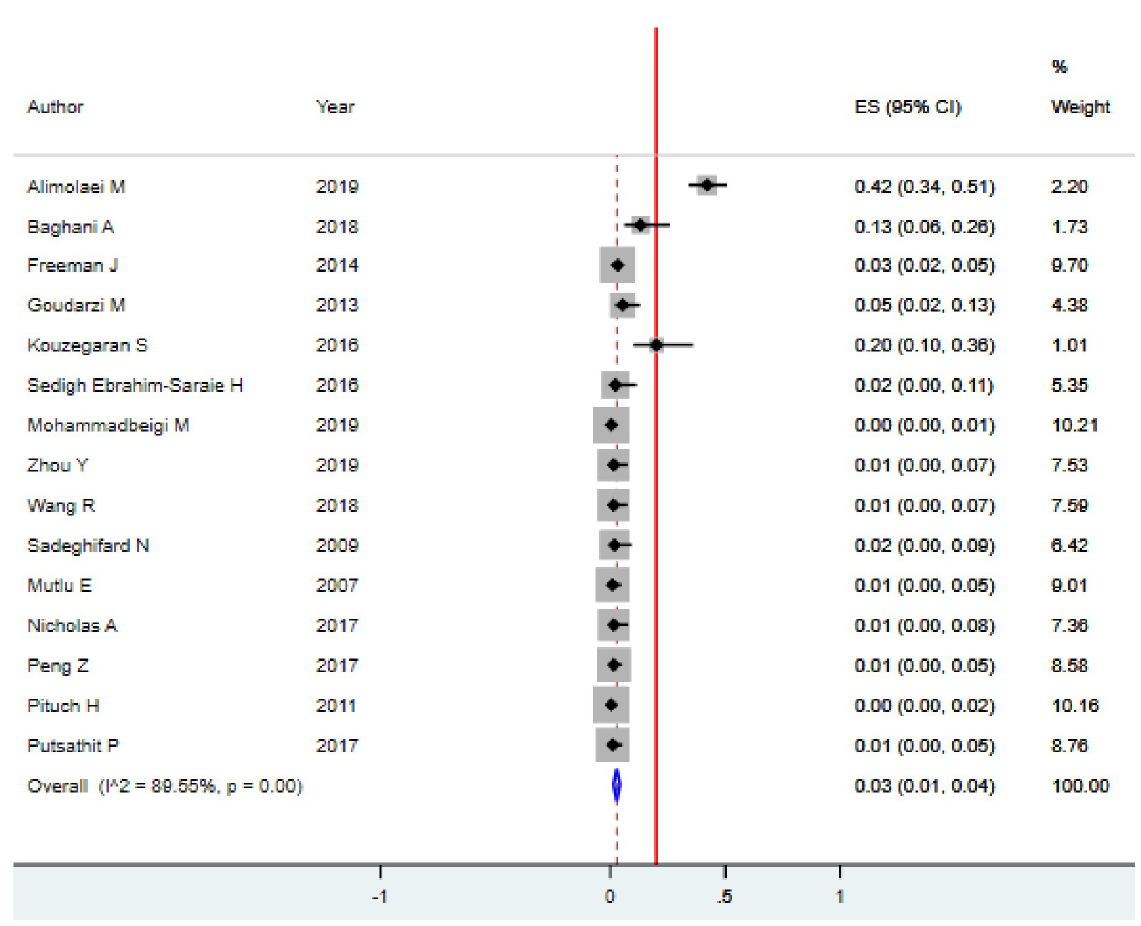
Fig 6. Forest plot for the proportion of vancomycin resistance of C . difficile among hospitalized diarrheal